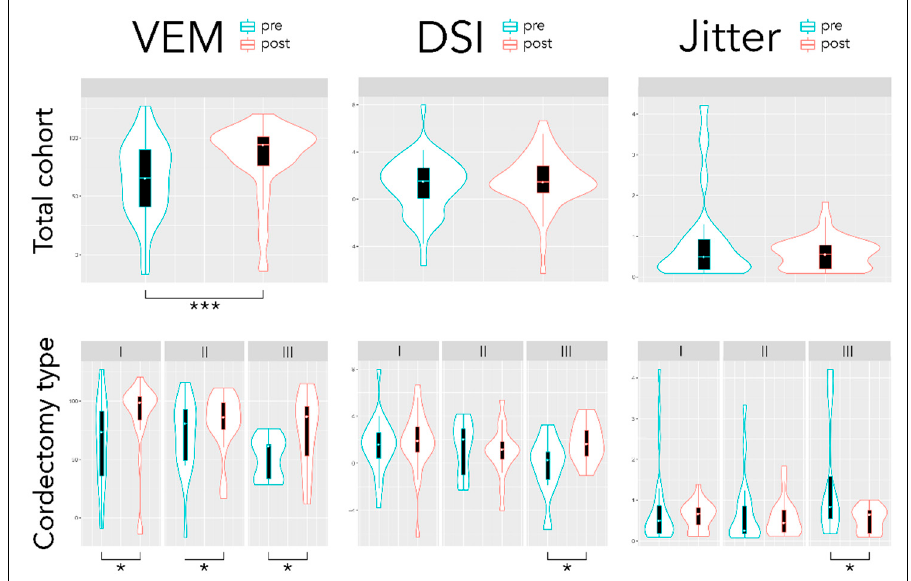
Figure 4. Objective acoustic parameters VEM, DSI, and jitter before and after pT1a removal con- cerning the total cohort and cordectomy types. Data are compared pre- vs. postoperatively via violin plots, i.e., box plots with kernel density plots rotated and surrounding them on each side. The boxplots display the median, quartiles, and the range of values covered by the data. The density curves display the full distribution of the data including any outliers. The level of significance is indicated as follows: * significant at 𝑝 < 0.05; ** significant at 𝑝 < 0.01; *** significant at 𝑝 < 0.001 (Wilcoxon signed-rank test).